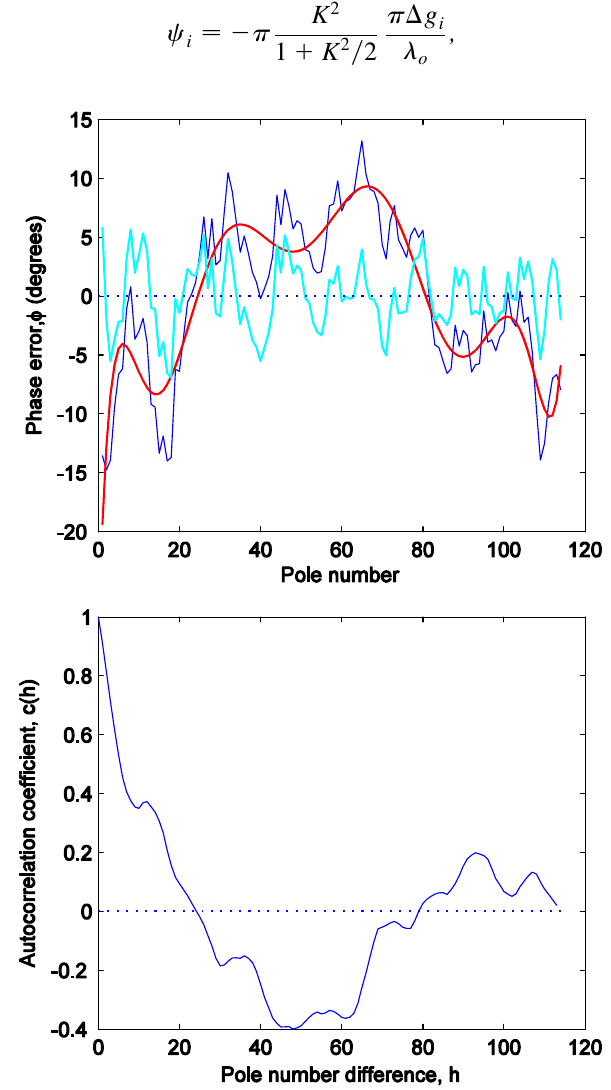
FIG. 2. Phase errors (upper) and corresponding autocorrelation coefficients (lower) for a set of random local phase errors, i.e., a ¼ 6 : 7 (cid:2) . The red and cyan curves random walk, scaled to give (cid:1) ’ show the decomposition into the sum of smooth (red) and random (cyan)